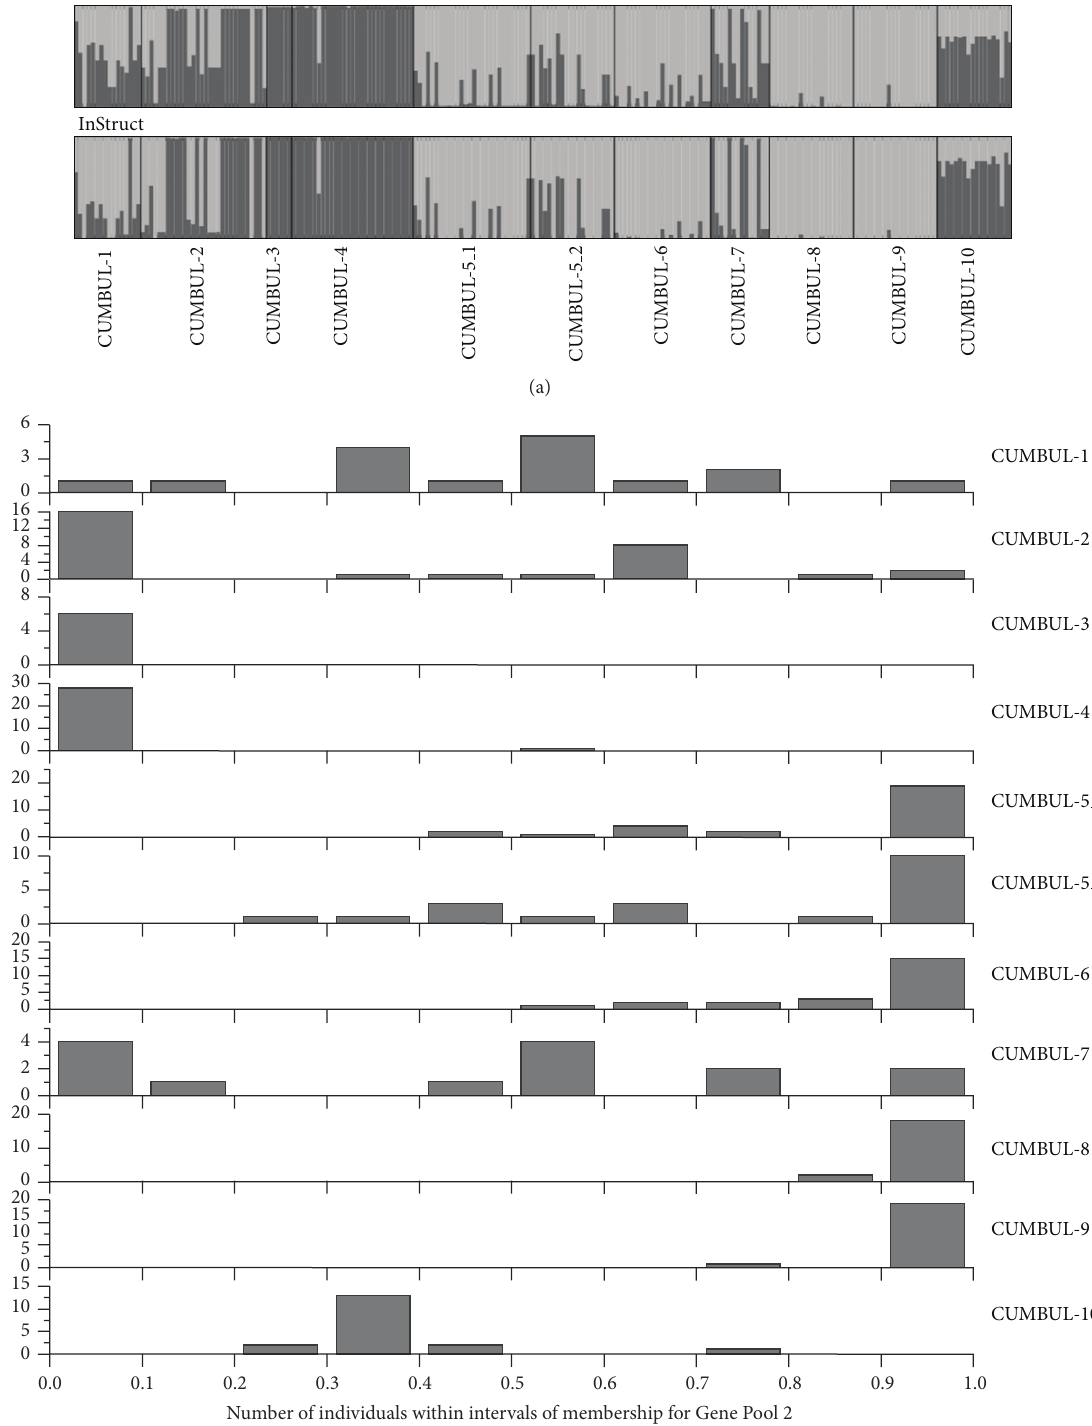
Figure 4: Results from STRUCTURE and InStruct analyses: (a) population structure obtained from STRUCTURE and InStruct analyses of eleven Bulgarian Orobanche cumana populations, with each individual being represented by a single vertical bar divided into two shades. Each shade represents one gene pool ( 𝐾 ) and the length of the shaded segment shows the individual’s estimated proportion of membership in that cluster and (b) number of O. cumana individuals from each Bulgarian population within intervals of membership for Gene Pool 2 in the STRUCTURE